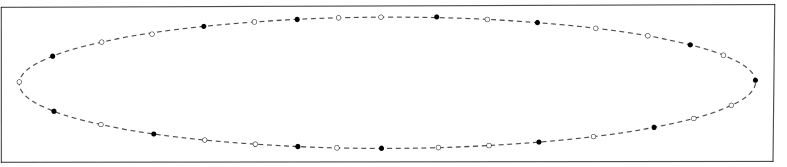
Figure 3. H 32 = B 32 with its nr -set.